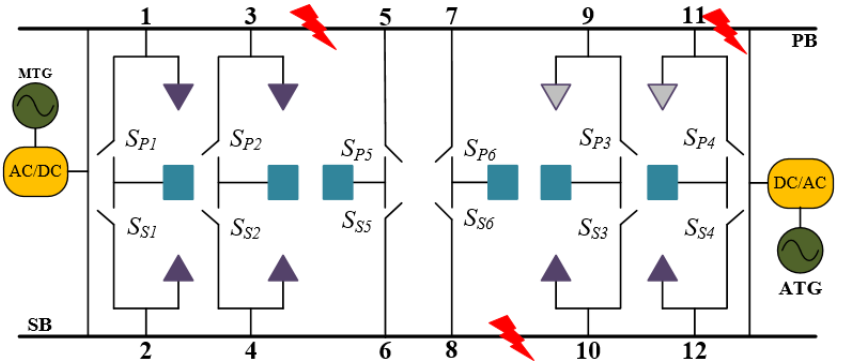
Figure 5. Schematic view of SPS under fault scenario 1. Table 4. Switch configuration in fault scenario